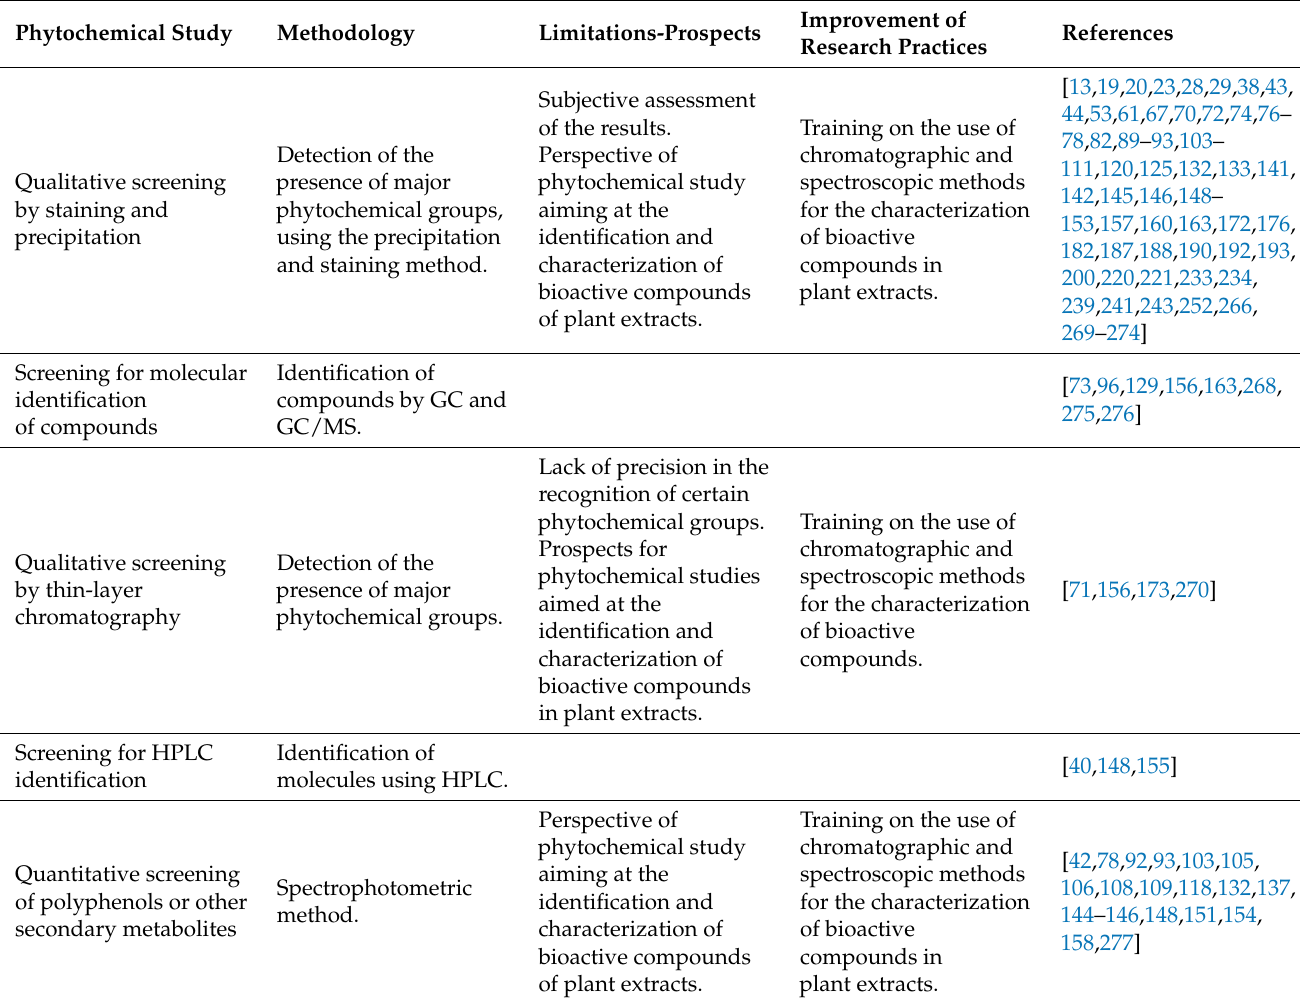
Table 3. Limitations of the phytochemical study methodology and proposals for practice